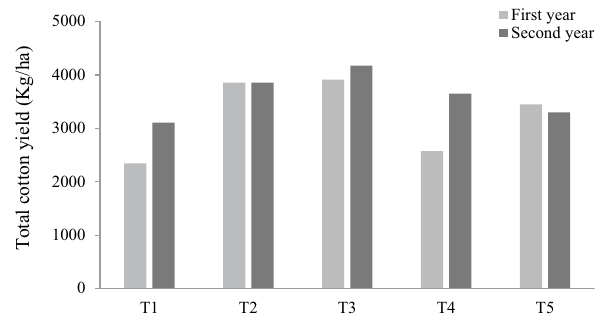
Fig. 10 Total cotton yield in the first and second years